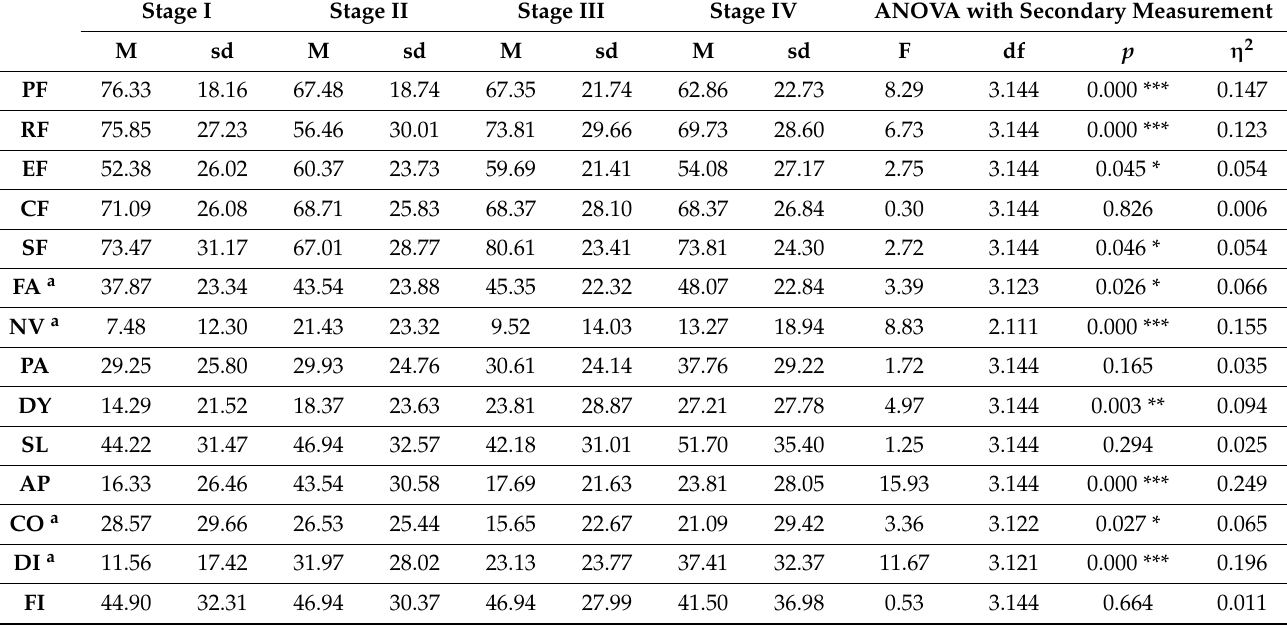
Table 7. Differences in QOL (Quality of Life) scores in different time periods.